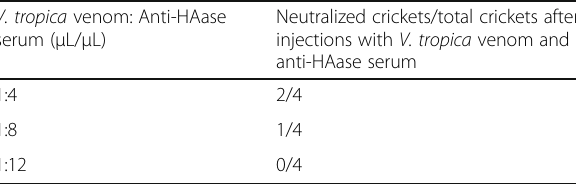
Table 2 The neutralization assay of V. tropica venom against anti-HAase serum in crickets ( Gryllus sp.)